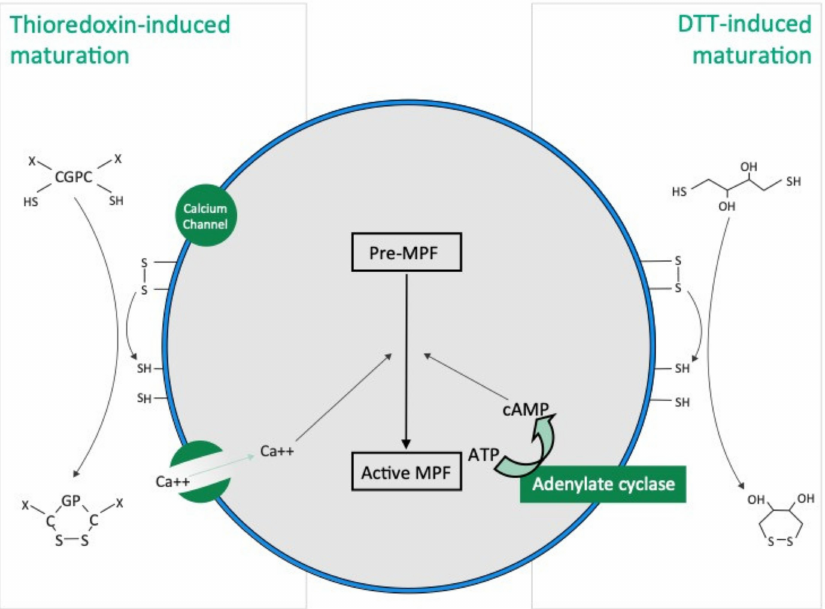
Figure 7. Hypothetical TRX and DTT induced oocyte maturation pathways based on the present study and the literature. DTT acts as a reducing agent by catalysing the reduction of disulphide bonds (R-SS-R), increasing the presence of sulfhydryl groups (i.e., R-SH), in hypothetical membrane proteins present at the surface of oocyte. Thioredoxins have a “CGPC” catalytic site and the presence of the two cysteines allows the reduction of disulphide bonds in hypothetical membrane proteins present at the surface of